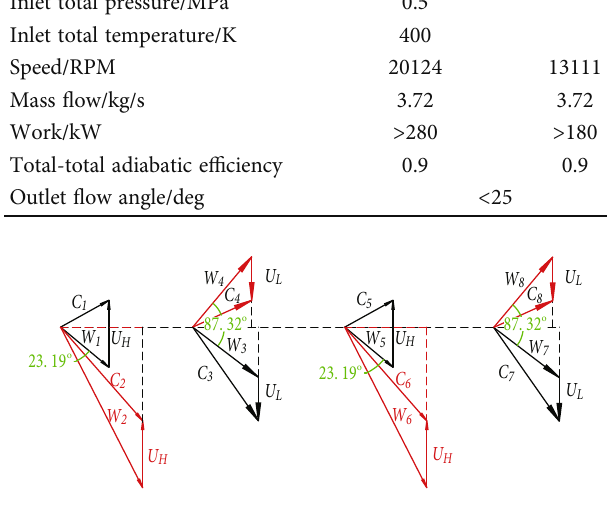
Figure 3: Velocity triangles at meanline section. Table 2: Turbine meanline design parameters.